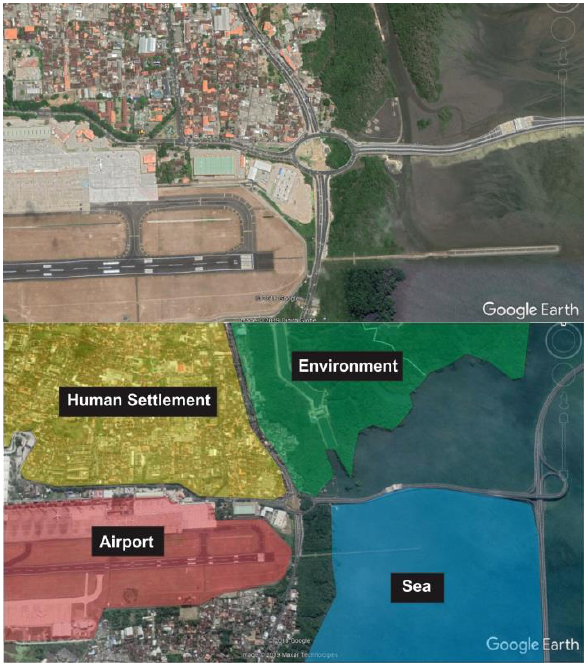
Figure 8. The presence of Tri Hita Karana concept in South of Bali